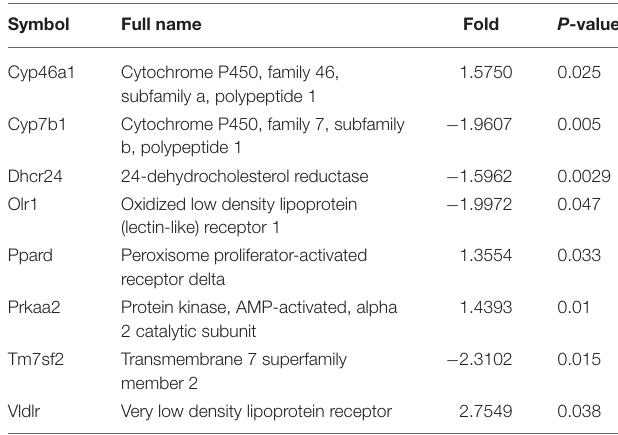
TABLE 2 | Differentially expressed genes involved in hepatic lipid metabolism and other related pathways between control and prenatally exposed offspring rats ( n =